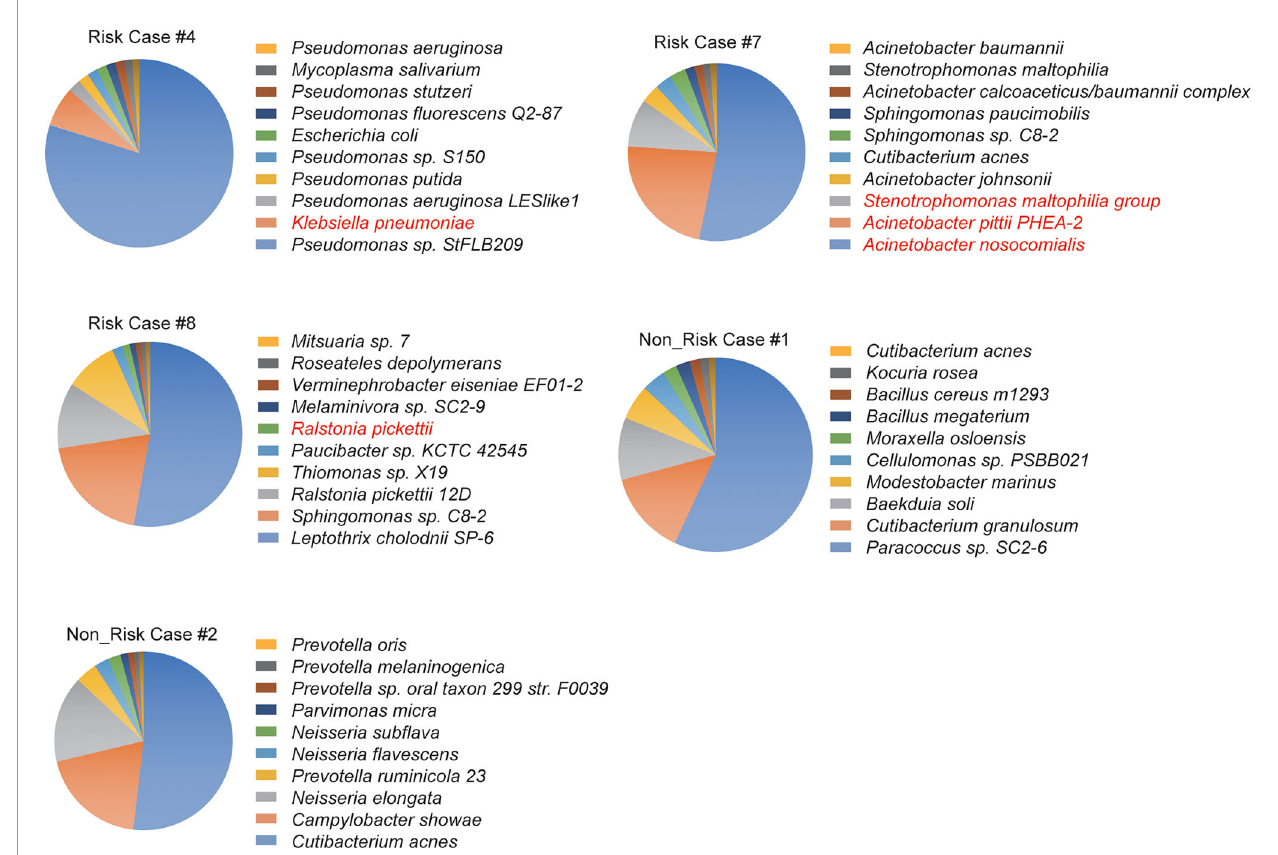
FIGURE 5 | Metagenomic analysis of BALF samples in the initial infection. The top 10 enriched bacteria or fungi were plotted. RNA-seq was performed with the BALF sample in patients with severe/critical COVID-19. All of these patients did not undergo secondary infection yet. All pneumonia-related bacteria were highlighted in red color. Three cases with secondary infection and two cases without secondary infection were included in this